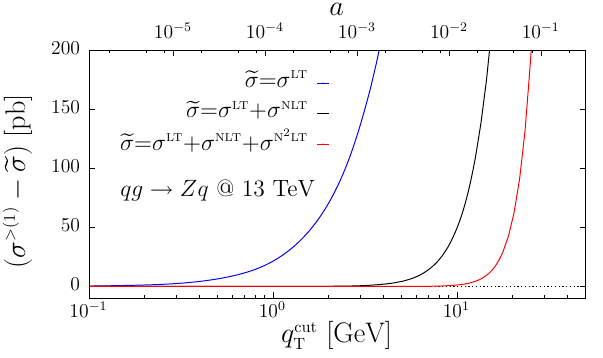
Fig. 1 Difference of the total cross sections of q cut , for Z boson production, in the qg → Zq (left pane) and in the T q ¯ q → Zg channel(rightpane).Thethreecurvescorrespondtothethree possible choices of ! σ : results for ! σ = σ LT are displayed in blue, for